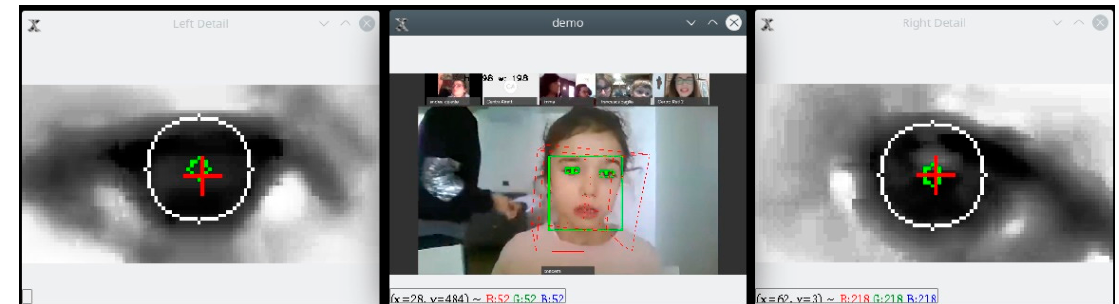
Figure 3. Eye-gaze tracking and head orientation estimation.